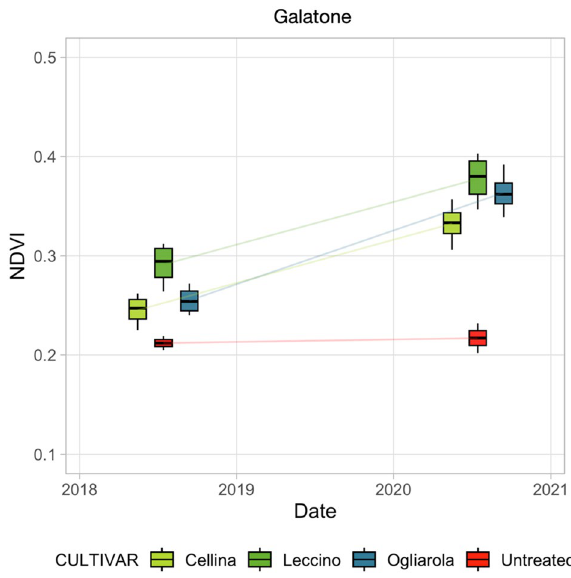
Figure 14. NDVI mean values from different cultivars, i.e., Leccino, Ogliarola Salentina, Cellina di Nardò, with respect to untreated trees in